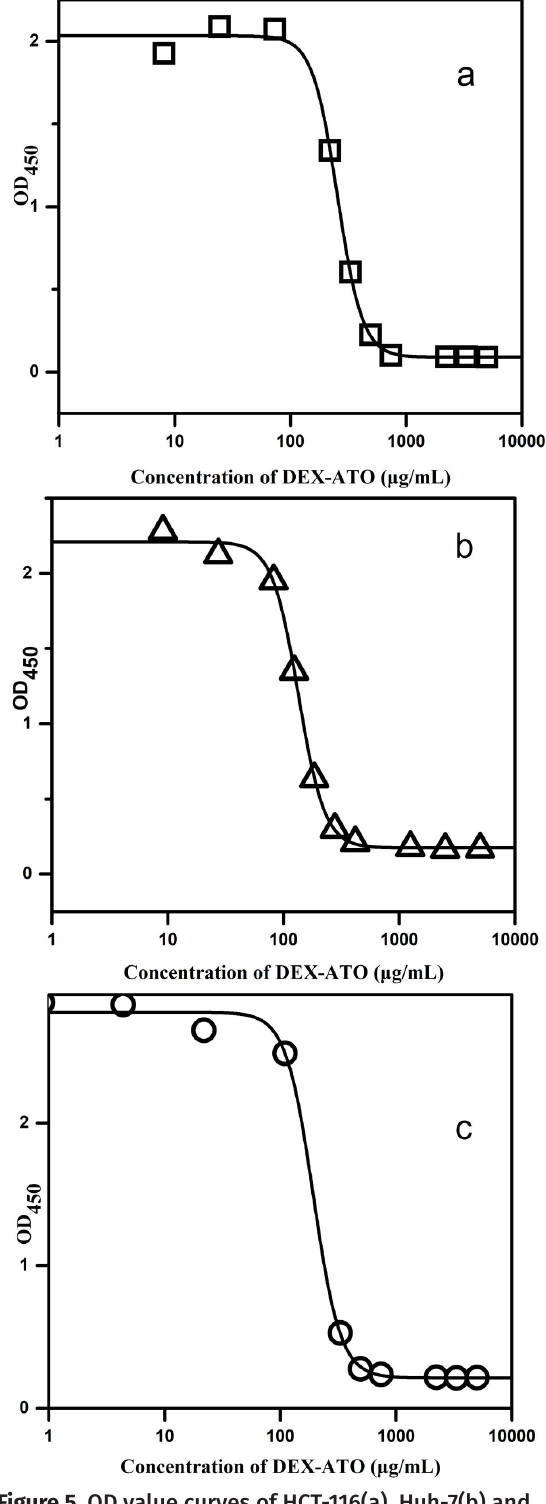
Figure 5. OD value curves of HCT-116(a), Huh-7(b) and SMMC-7721(c) cells as a function of the concentration of